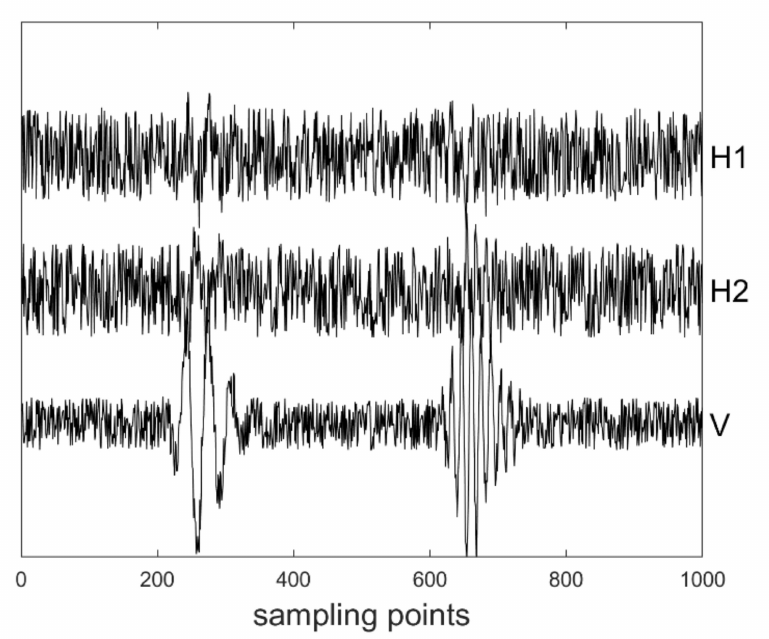
Figure 3. The synthetic data contaminated with random